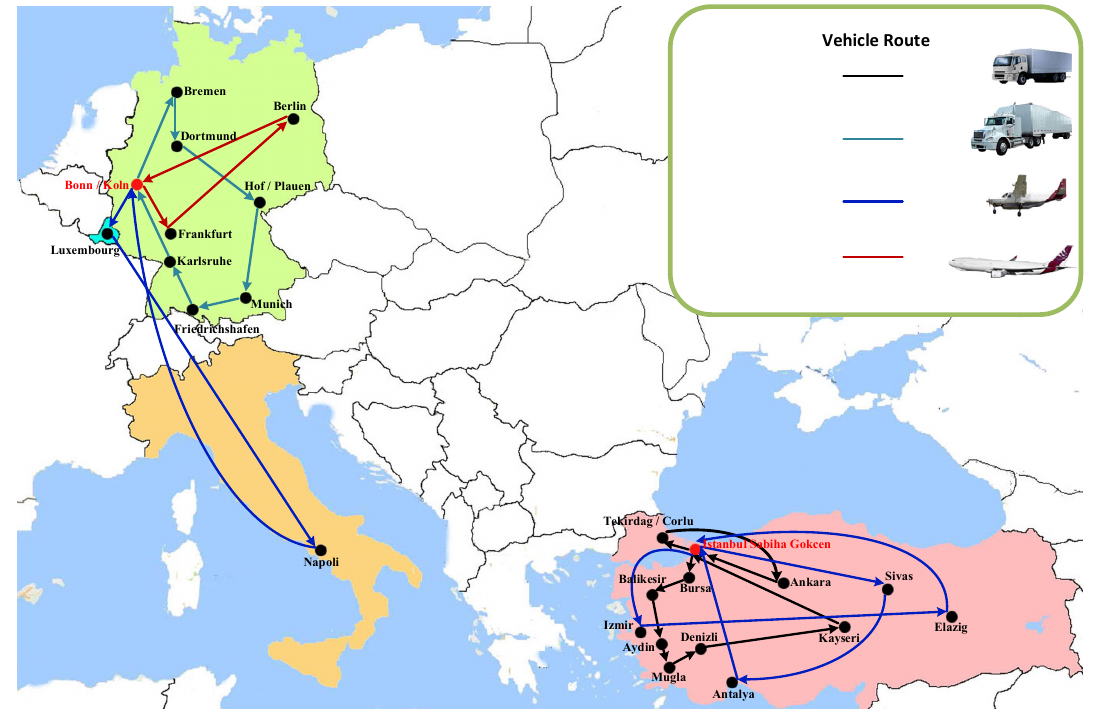
Fig. 9. The routes found by the HGA-VNS algorithm for the fast demand